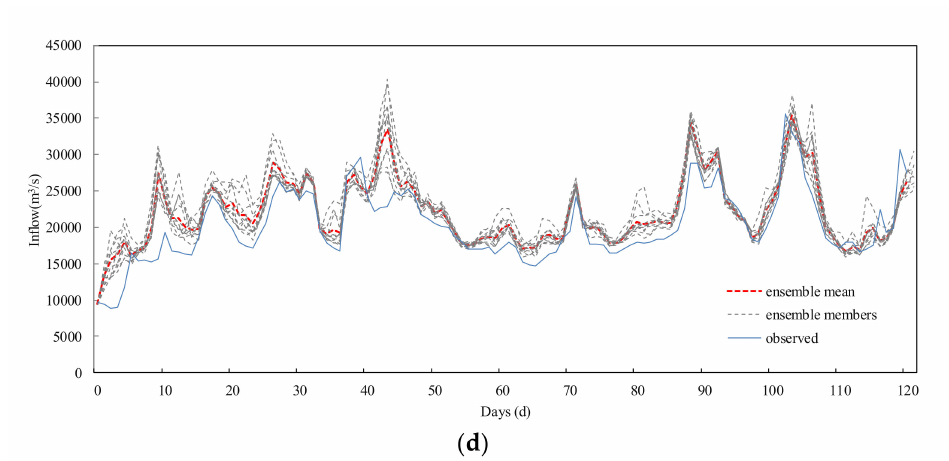
Figure 5. Simulated result of the four scenarios: ( a ) Observed data + Xin’an Jiang model, ( b ) GEFS data + Xin’an Jiang model, ( c ) Corrected GEFS data + Xin’an Jiang model, and ( d ) Bayesian ensemble forecast.